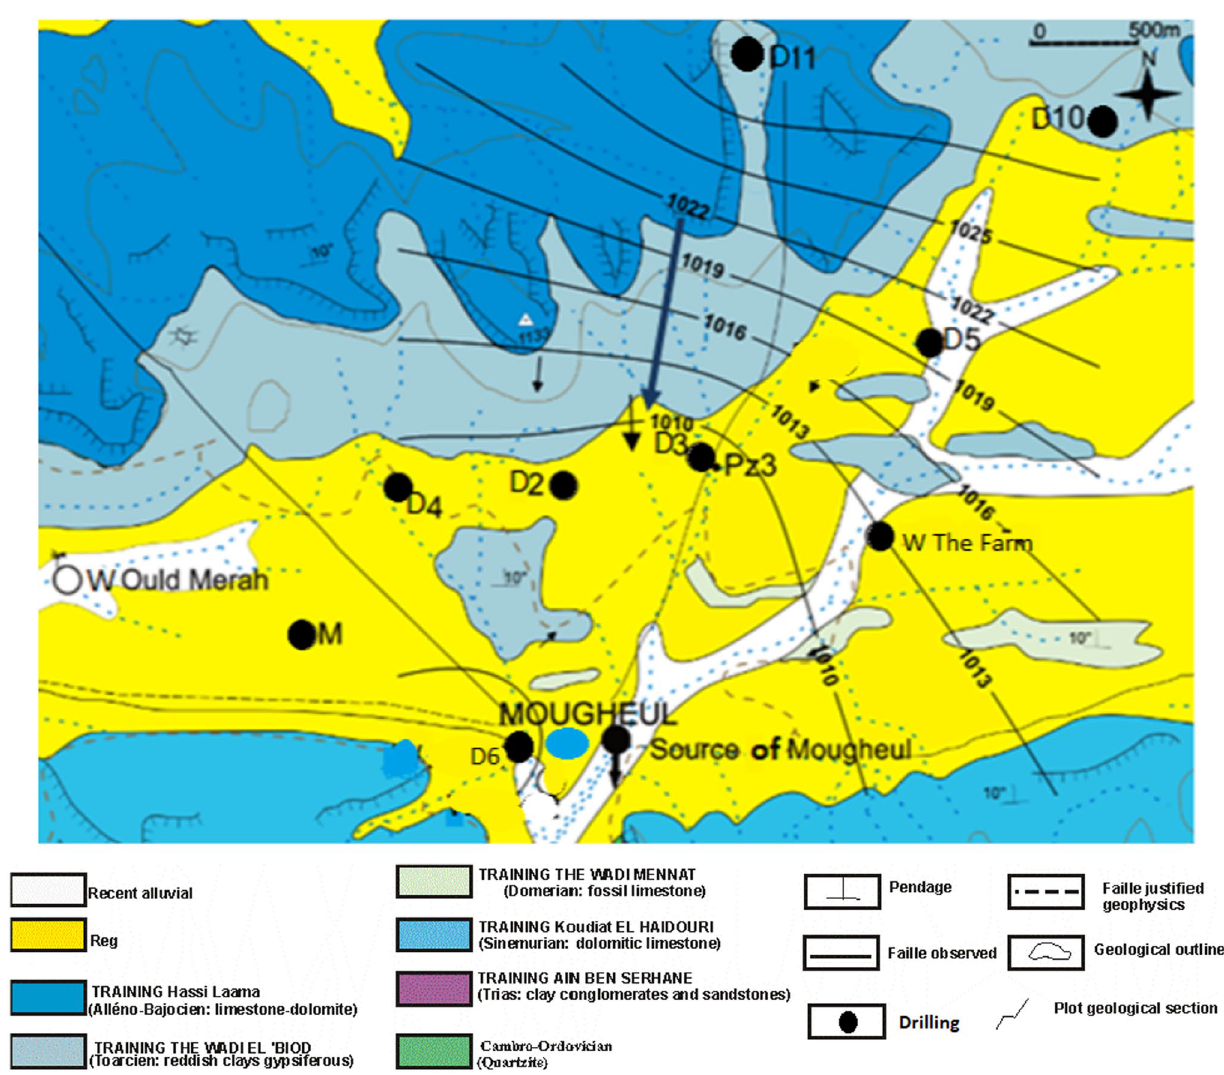
Fig. 5 Piezometric map of the lower Jurassic aquifer of Mougheul December 2009 (Mebarki